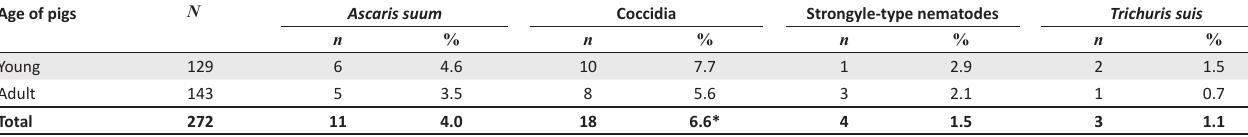
TABLE 2: Prevalence of gastrointestinal parasites in pigs according to age. Age of pigs